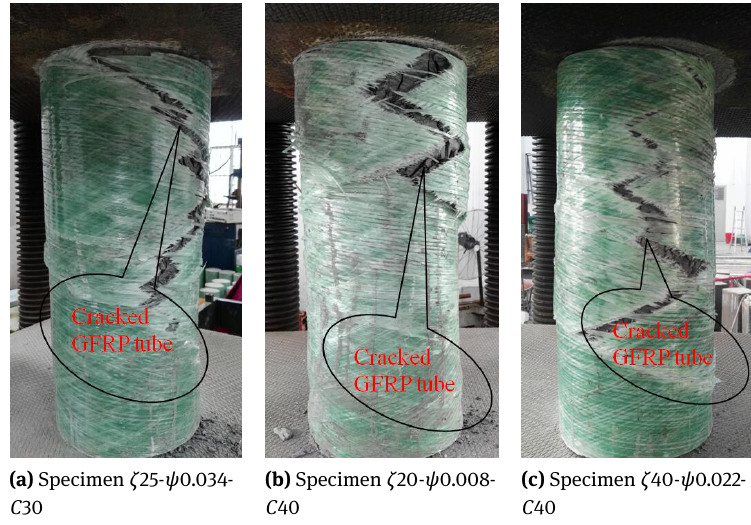
Figure 7: Failure mode of the columns